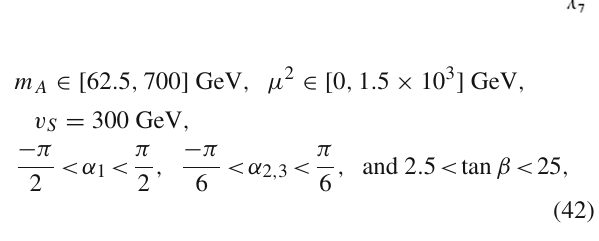
Fig. 1 The left panel shows the parameter space allowed by the theoretical constraints (Unitarity, Perturbativity and BFB) for ( λ 7 ,λ 8 ) for λ = ( 1 , 4 , 12 ) . Note the 6 complete overlap between black, black and red for positive λ 6 , 7 . The right panel illustrates the correlation between oblique parameters S and T. The errors for χ 2 -square fit are 99.7% CL ST (black), 95.5% CL (green) and 68% CL